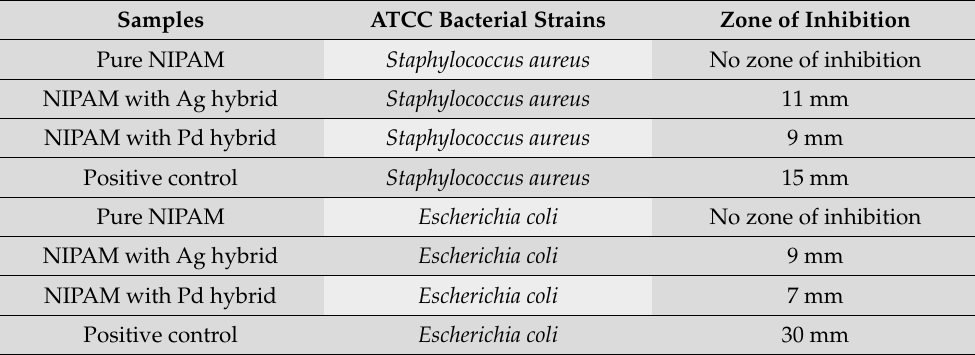
Figure 7. Antibacterial activities of pure NIPAM cryogel (CR), Ag-embedded NIPAM-based cryo- gels (CR-Ag) and Pd-embedded NIPAM-based cryogels CR-Pd against Staphylococcus aureus and Escherichia coli. Table 1. Zone of inhibition of both E. Coli and S. Aureus.